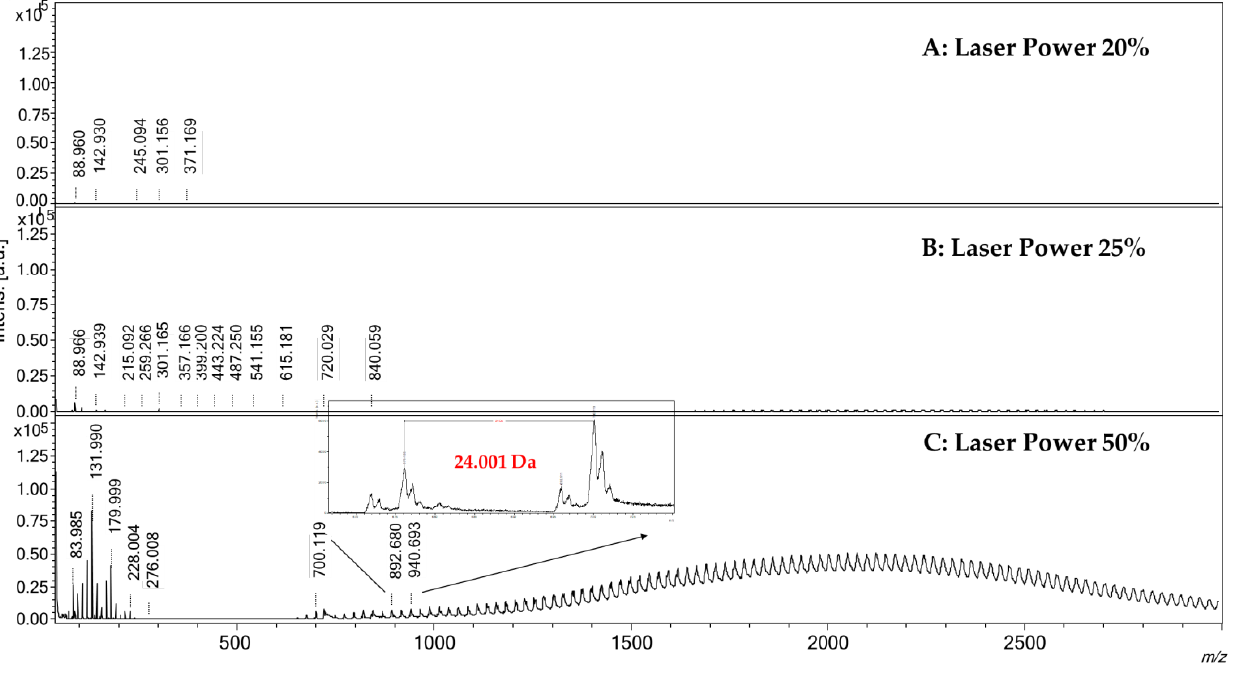
Figure 1. LDI-MS spectra acquired in positive ionization mode of the SWCNH-based surface using different laser power. Panel ( A ): Laser Power 20%; Panel ( B ): Laser Power 25%; Panel ( C ): Laser Power 50%. In panel ( C ) is possible to note the presence of several signals in the range 600 – 3000 m / z , separated by 24 mass units, due to the ionization of SWCNHs.